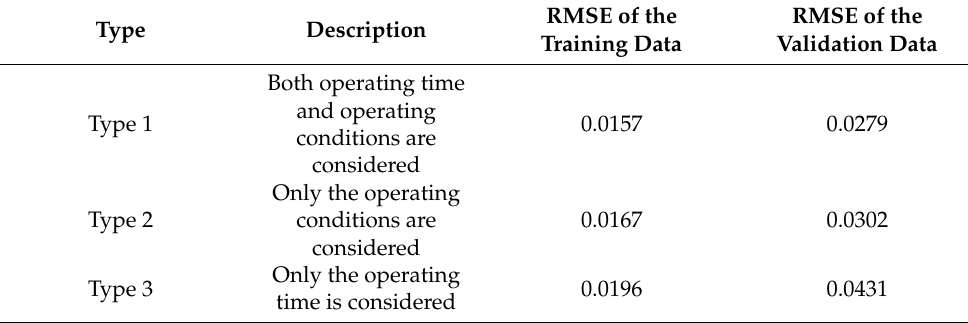
Table 5. The results of the three types of model inputs.